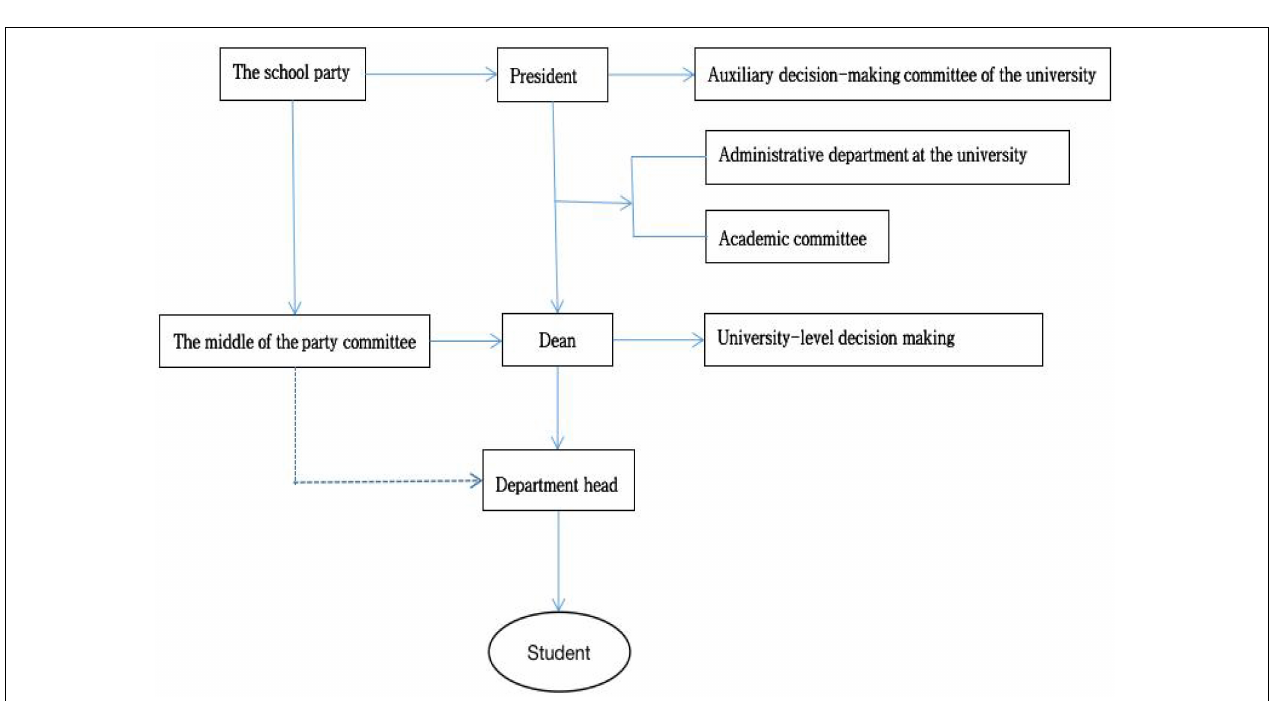
FIGURE 2 | Schematic diagram of university governance